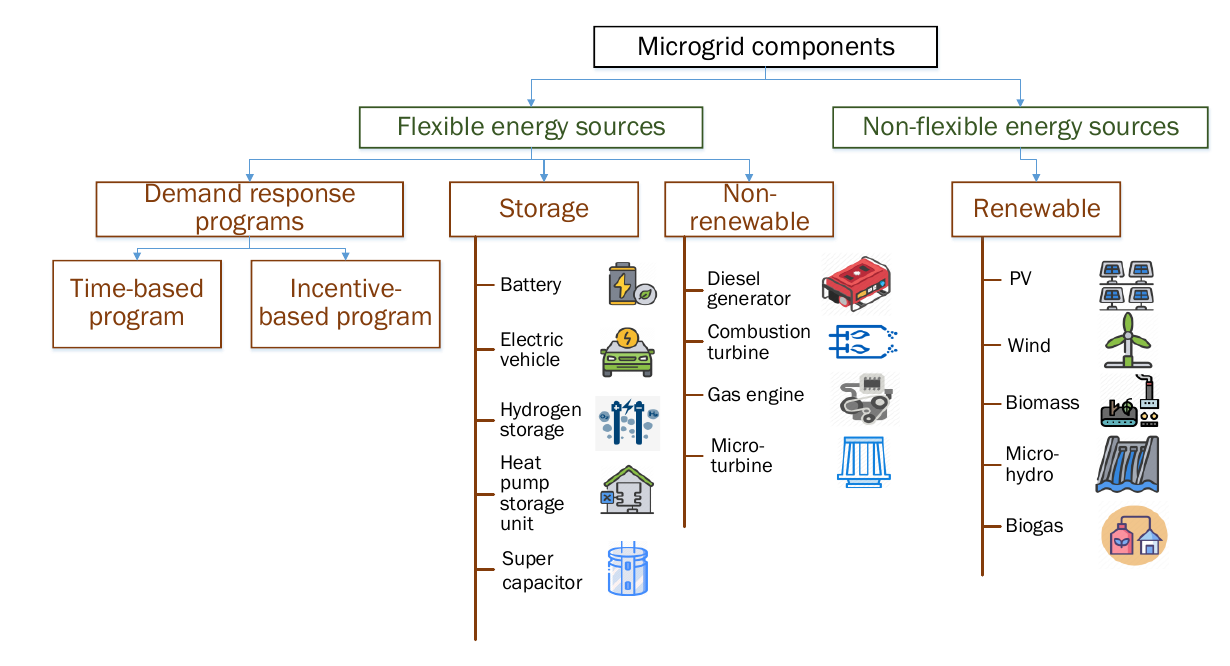
Fig. 1. Microgrid components